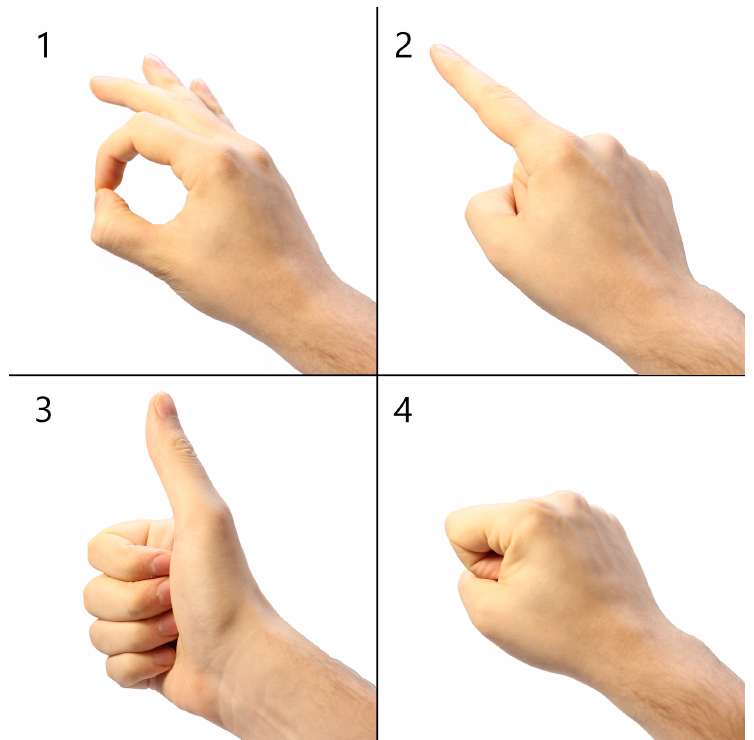
Figure 2. Hand gestures used in a hand tracking based control scheme. ( 1 ) Pinch gesture—create new atoms and bonds. ( 2 ) Point gesture—select atoms and bonds for measuring and editing, interact with menus. ( 3 ) Thumb up—delete atoms or bonds. ( 4 ) Grab gesture—move atoms, rotate bonds or rotate